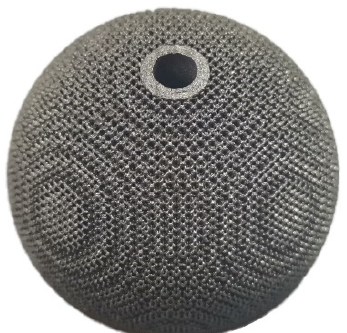
Figure 15. Acetabular cup with a gradient porous structure outer surface formed using SLM.